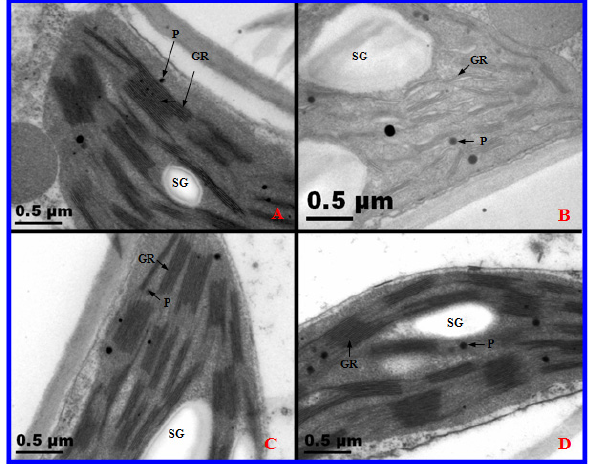
Figure 8. Transmission electron microscopy observations of chloroplasts in diploid (2×) and tetraploid (4×) Robinia pseudoacacia after one day and 10 days of salt treatment. ( A ) 0 day, 2×; ( B ) 10 days, 2×; ( C ) 0 day, 4×; ( D ) 10 days, 4×. Gr, granum; thylakoid (Th); P, plastoglobule; SG, starch